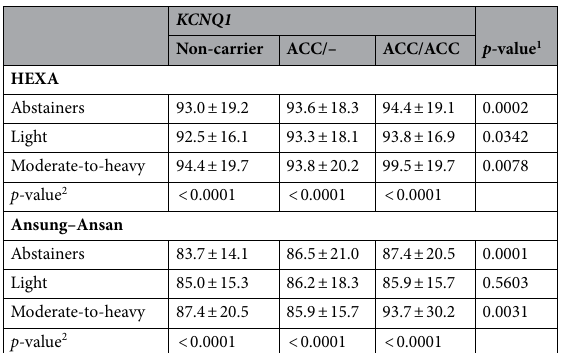
Table 2. Effect of the KCNQ1 haplotype on the fasting glucose level according to alcohol consumption in the HEXA and Ansung–Ansan cohorts. Data are expressed as the mean ± standard deviation fasting glucose level. 1 One-way ANOVA was used to assess the relationships with the KCNQ1 haplotype. 2 Between alcohol consumption.